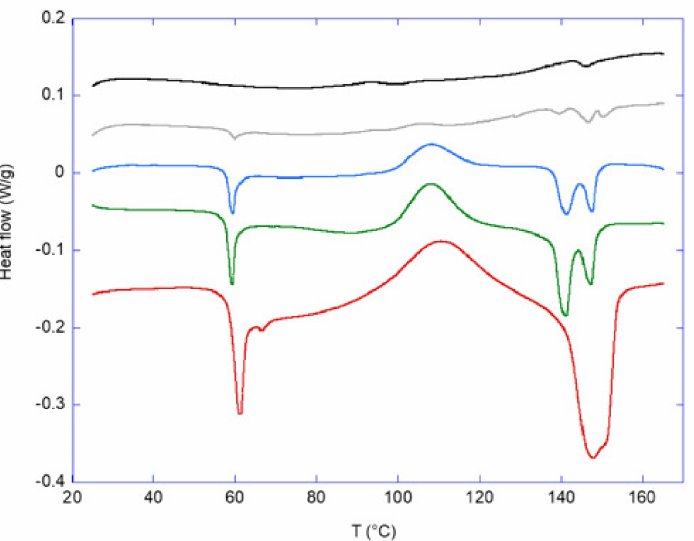
Figure 3. DSC data for the five film samples. From top to bottom, the plots correspond to 100: 0 CSM: PLA (black); 90: 10 CSM: PLA (grey); 70: 30 CSM: PLA (blue); 50: 50 CSM: PLA (green); and 0: 100 CSM: PLA